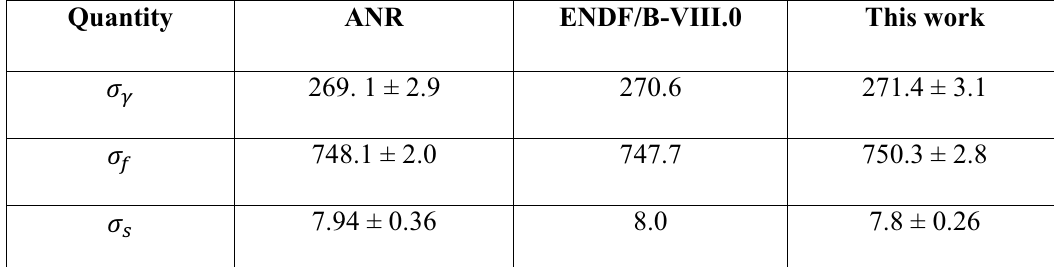
Table III: Thermal cross section values (in barns) calculated with